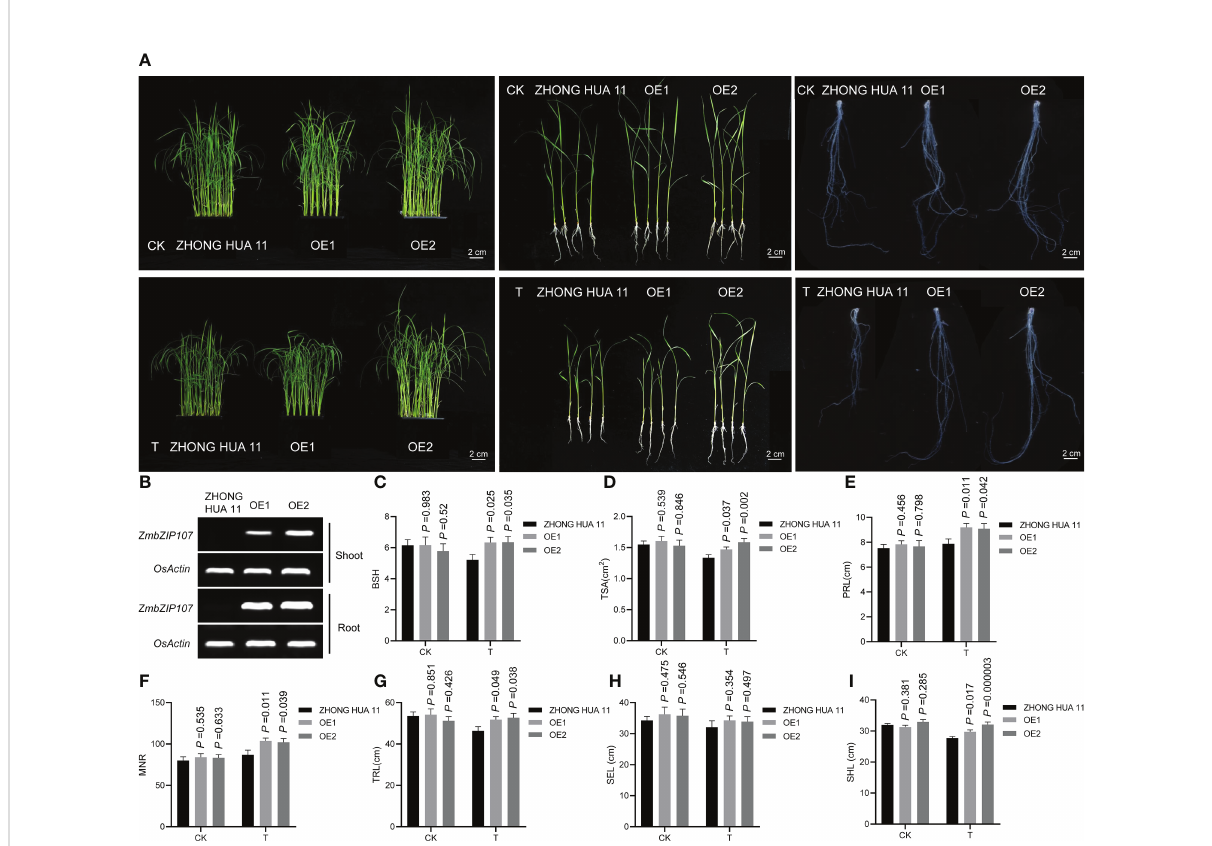
FIGURE 5 Heterologous expression of ZmbZIP107 improving lead tolerance in rice. (A) Phenotypic comparison between ZHONG HUA 11 and the overexpression lines (OE1 and OE2) under CK and T conditions. CK, normal condition; T, Pb treatment, (Scale bar, 2 cm). (B) Expression of ZmbZIP107 in the roots and shoots of the OE lines under Pb treatment, detected using semi-quantitative RT-PCR. (C – I) Root system architecture (RSA) of ZHONG HUA 11 and the OE lines under CK and T conditions. CK, normal condition; T, Pb treatment. BSH, root bushiness; TSA, total surface area; PRL, primary root length; SEL, secondary root length; MNR, maximum number of roots; TRL, total root length; SHL, Shoot